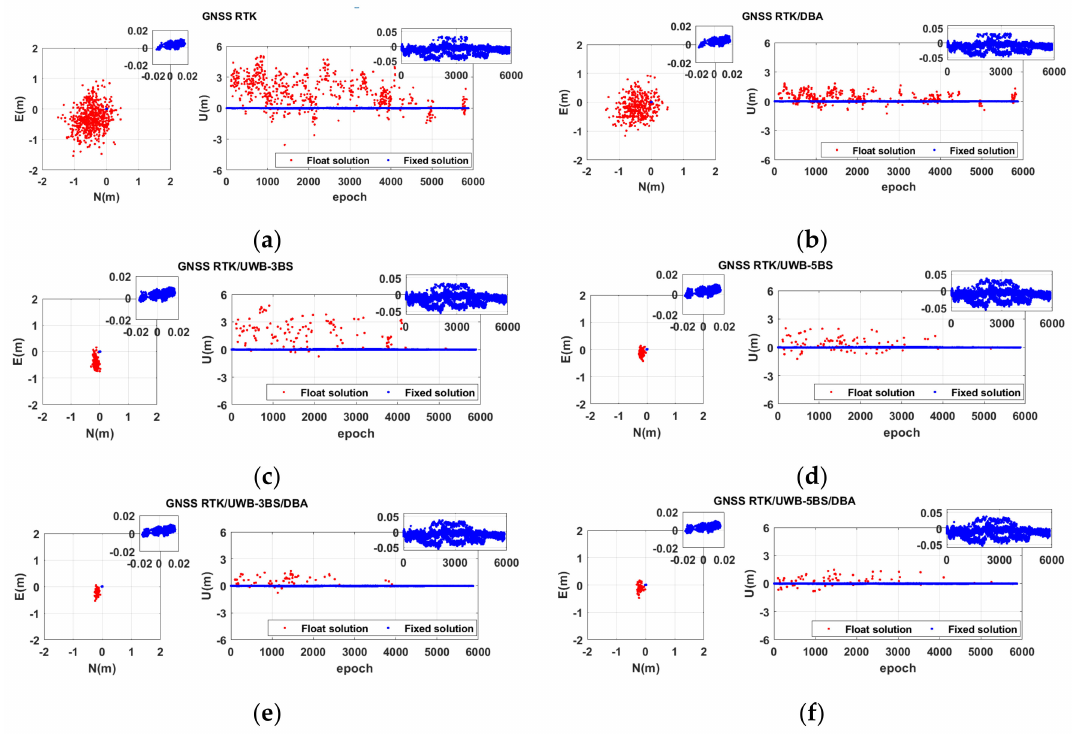
Figure 7. GNSS RTK/UWB/DBA fusion positioning model error in the N/E/U directions at a 30 degree elevation mask angle: ( a ) GNSS RTK; ( b ) GNSS RTK/DBA; ( c ) GNSS RTK/UWB − 3BS;